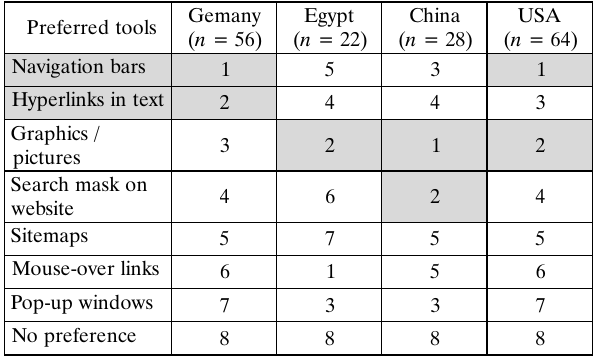
Table 1. Ranking of preferred navigation tools